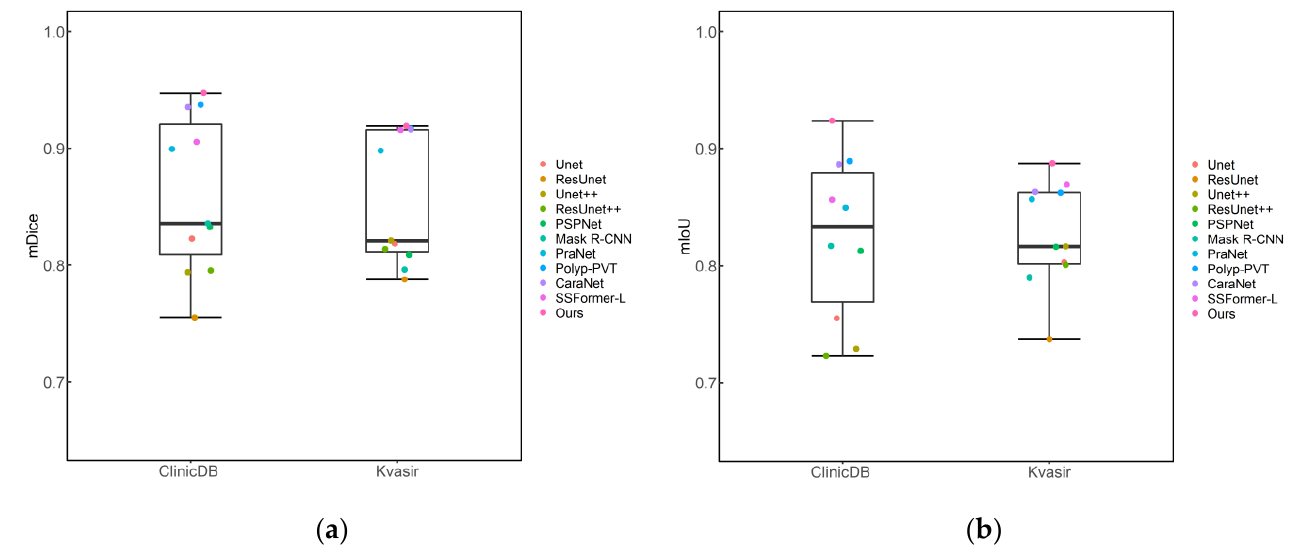
Figure 6. The generalization ability was evaluated by box plots. ( a ) The proposed model and comparison methods in Kvasir-SEG and CVC-ClinicDB mDice results. ( b ) The proposed model and comparison methods in Kvasir-SEG and CVC-ClinicDB mIoU results.